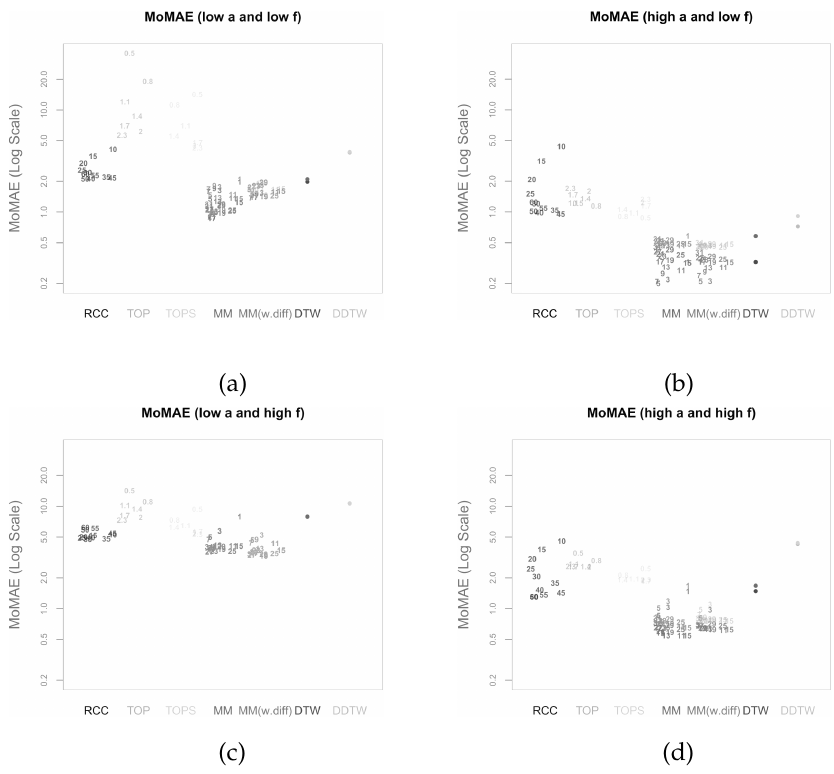
Figure 12. Mean of MAE (MoMAE) for ( a ) low a and low f ; ( b ) high a and low f ; ( c ) low a and high f ; ( d ) high a and high f . Numbers characterize the value of the corresponding